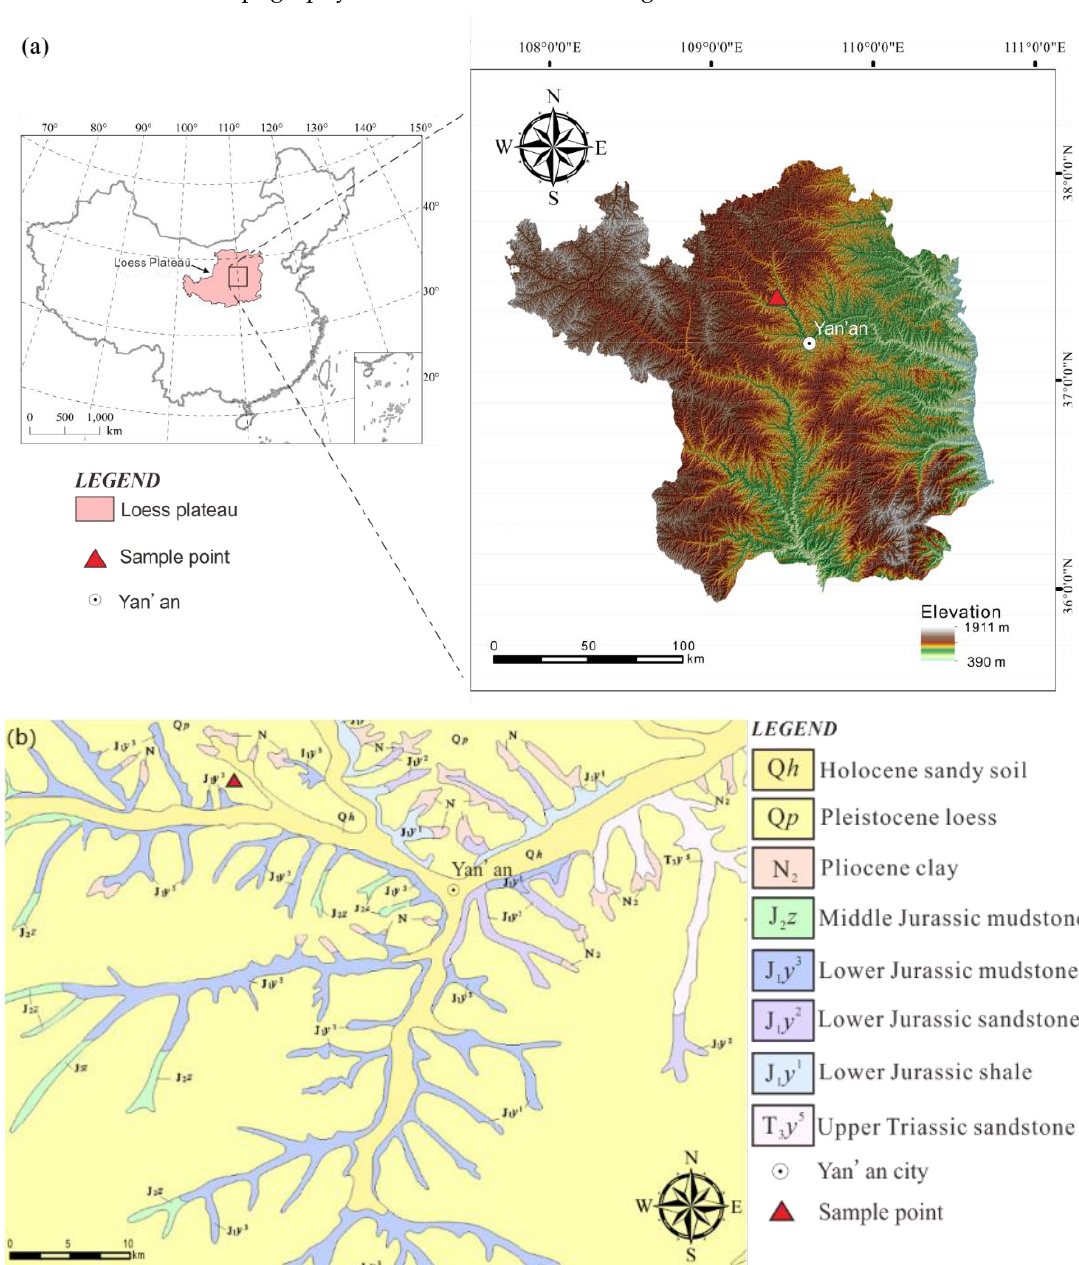
Figure 1. ( a ) Location of study area; ( b ) Associated geological map of the sample point (Geological map is modified based on Geological Map of China).